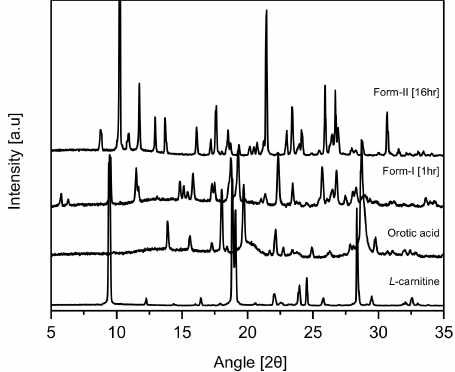
Figure 2. Powder X-ray diffraction (PXRD) patterns of